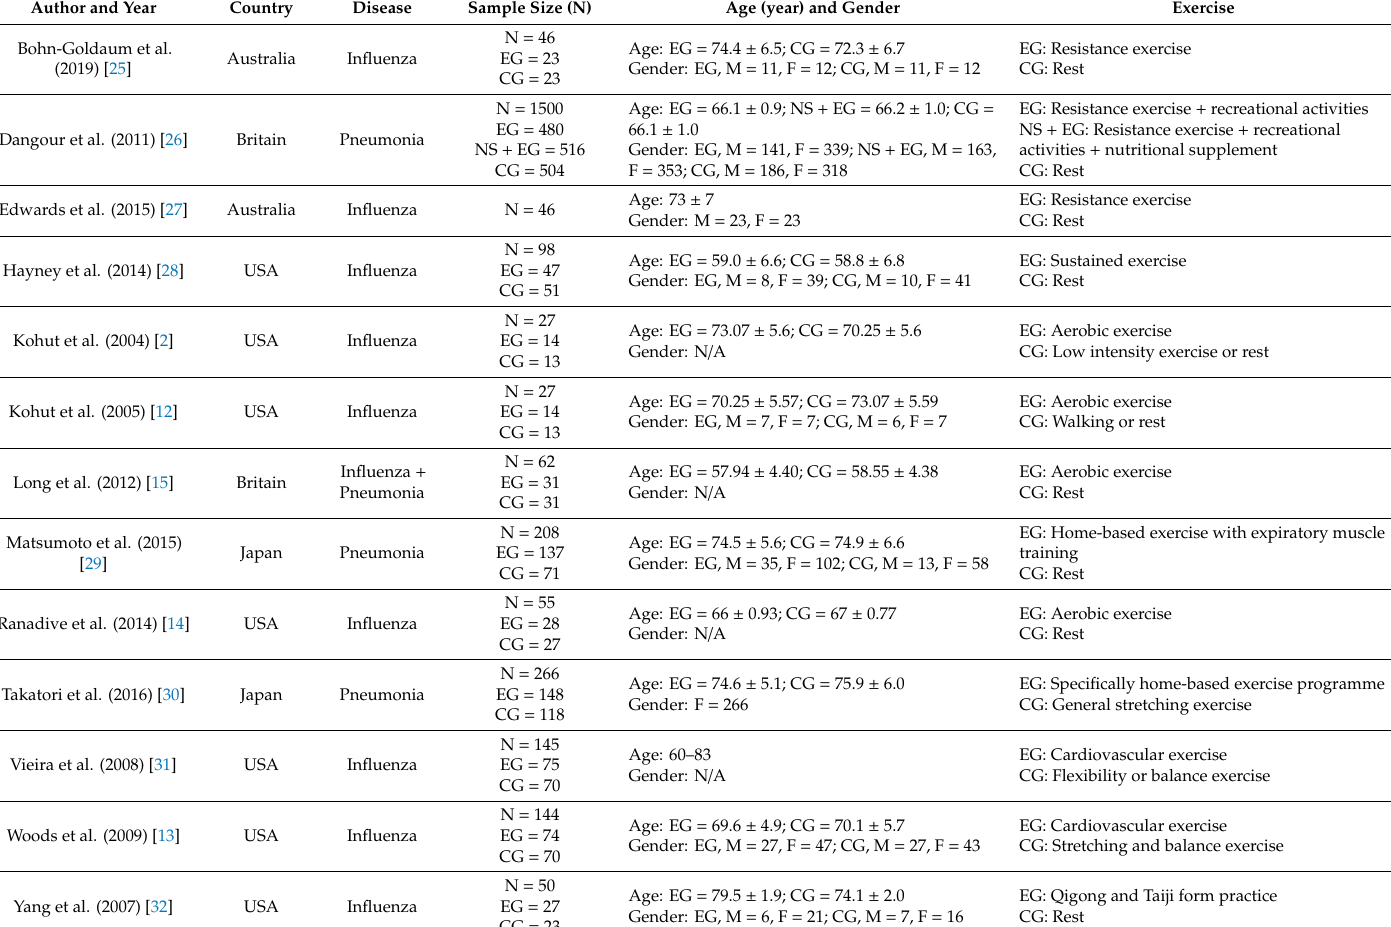
Table 1. The study characteristics of randomized controlled